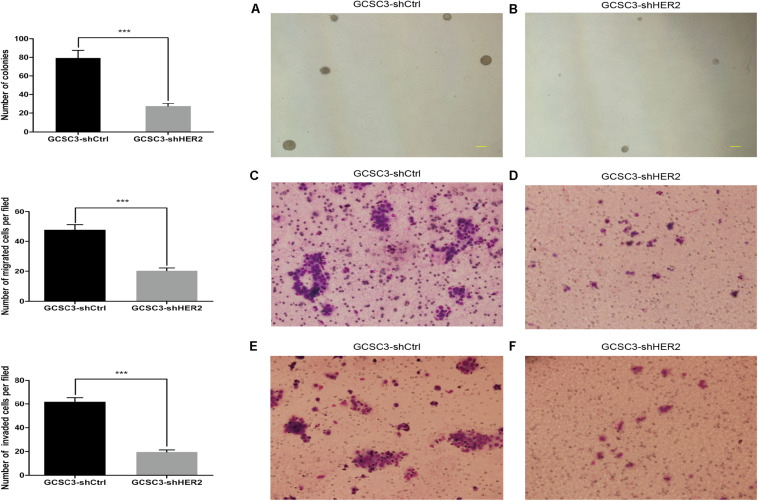
Ability of colony formation, invasion, and migration in GCSCs was detected after down-regulation of HER2. Pictures (A,B) show the colonies of GCSC3-shCtrl and GCSC3-shHER2, respectively. Representative pictures were taken at ×40 magnification, and scale bars represent 200 μm. The result showed GCSC3-shCtrl had a higher colony formation rate than GCSC3-shHER2 (79.33 ± 4.63 vs. 27.33 ± 1.76, p < 0.001); data were expressed as mean ± SEM, ***p < 0.001. Pictures (C,D) show that GCSC3-shCtrl had a higher capacity of migration than GCSC3-shHER2 (47.93 ± 3.38 vs. 20.27 ± 2.13, p < 0.001); and pictures (E,F) show that GCSC3-shCtrl had a higher capacity of invasion than GCSC3-shHER2 (61.87 ± 3.71 vs. 19.67 ± 1.71, p < 0.001). Representative pictures were taken at ×200 magnification. Data were expressed as mean ± SEM, ***p < 0.001.